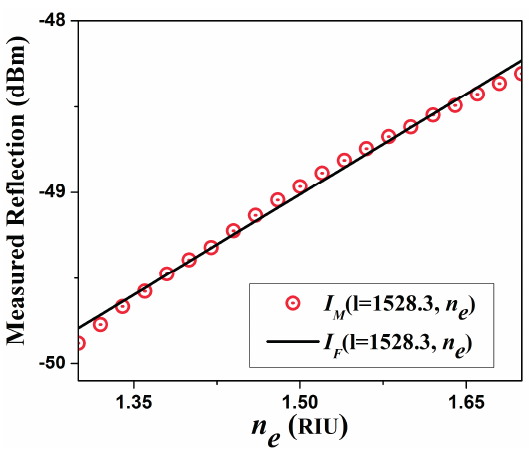
Figure 7. Measured reflected energy at λ 1528.3 = nm as a function of the exit medium refractive index and its linear